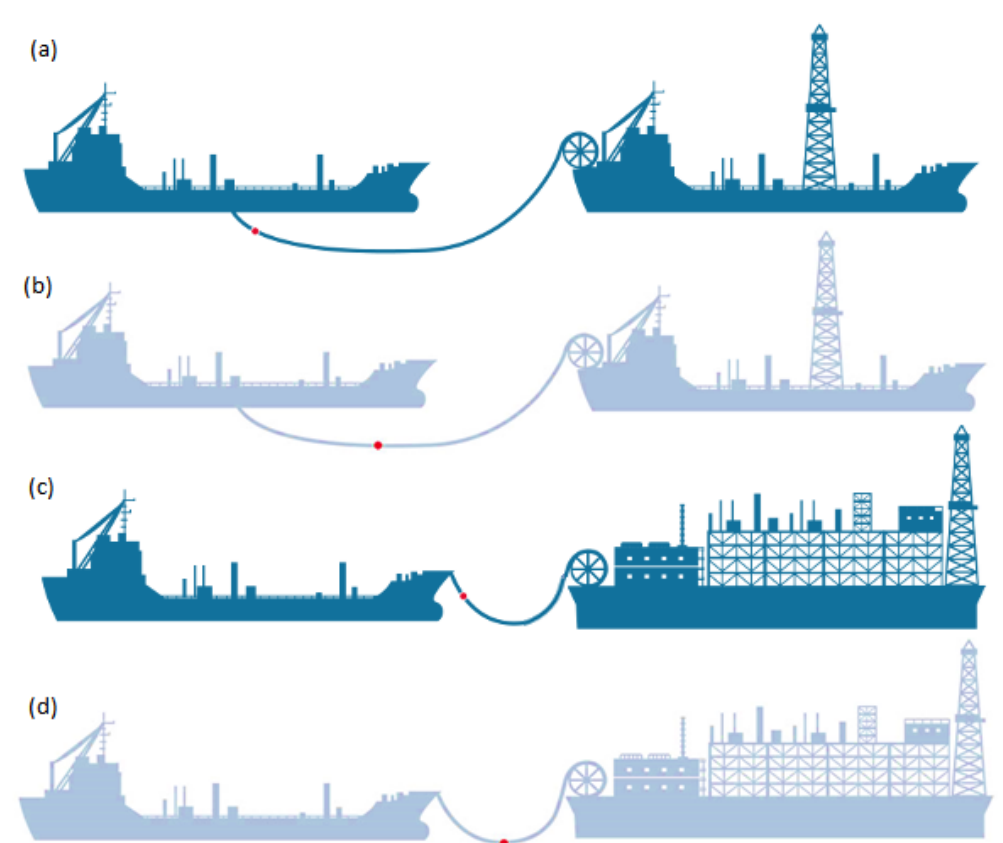
Figure 21. MBC Installation options for Tanker Midship Manifold configurations in ( a ) position 1, ( b ) position 2, and for Bow Loading configurations in ( c ) position 3, ( d ) position 4.